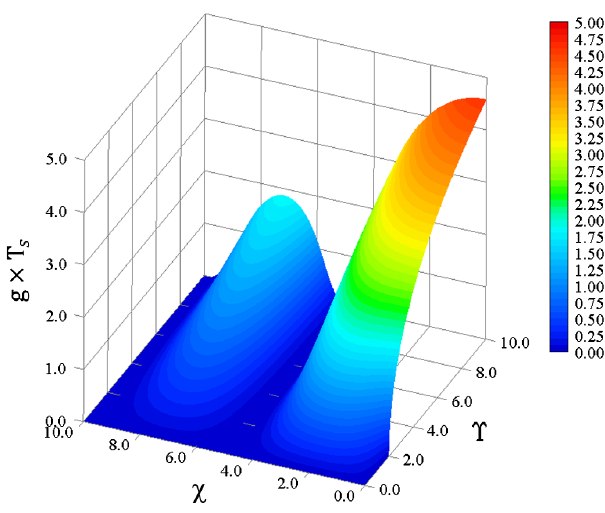
FIG. 7. Three-dimensional contour plot in the square well model for the growth factor g × T for positive χ